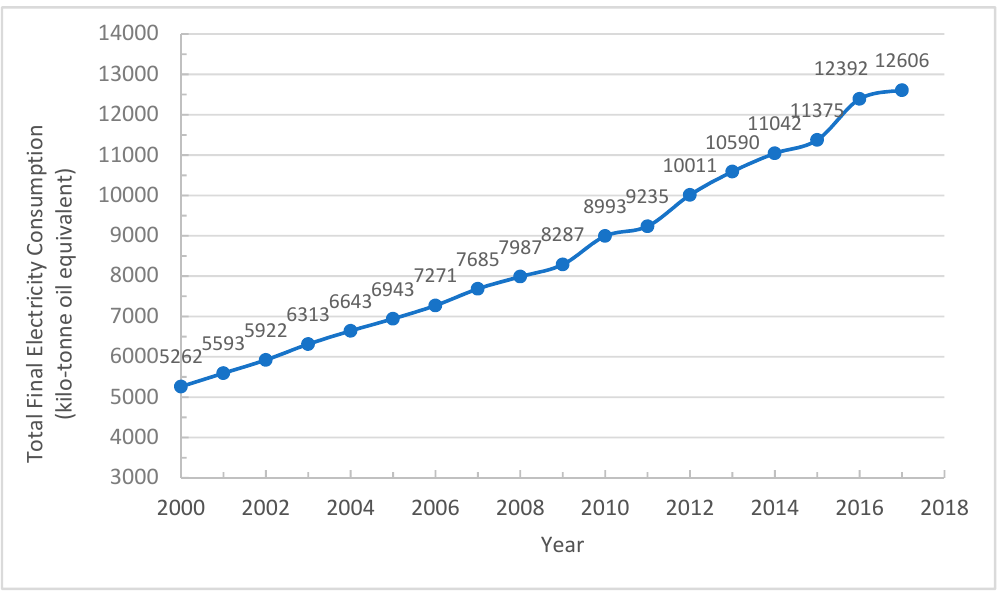
Figure 2. Final electricity consumption, kilo-tonne oil equivalent (ktoe) in Malaysia [8].